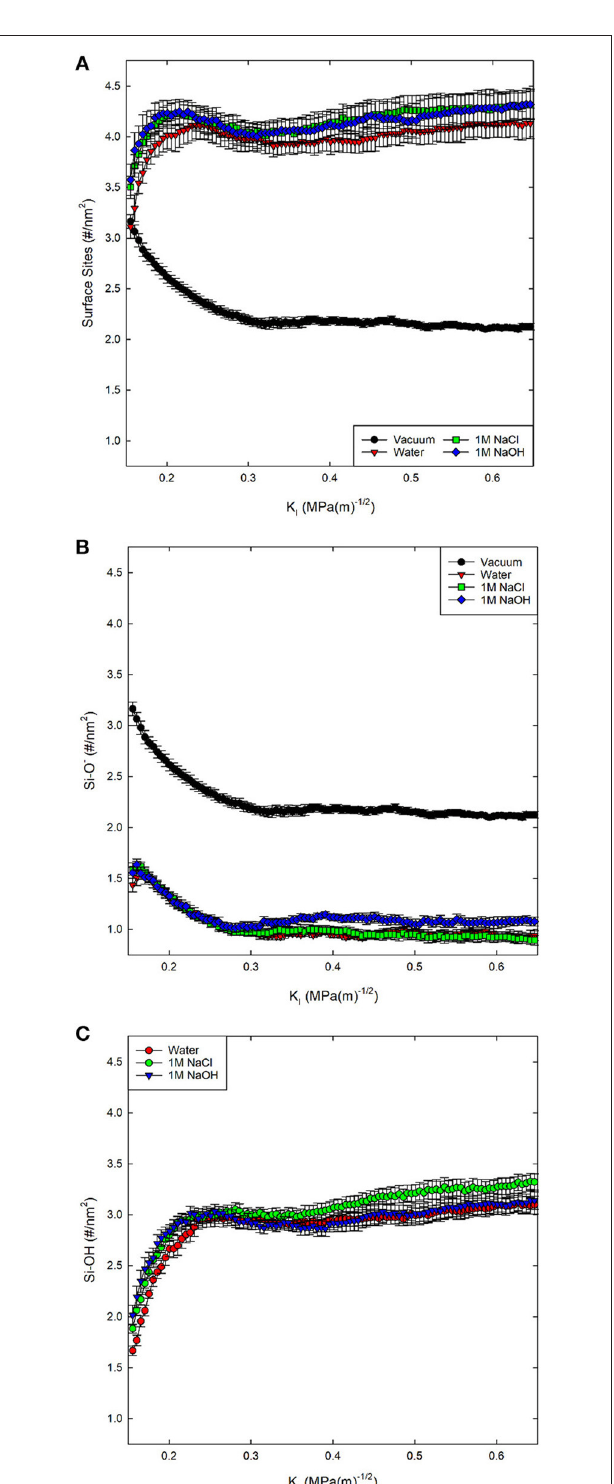
FIGURE 2 | Total concentration of (A) surface sites (Si-OH, Si-O − , Si-OH 2 ) on the fracture surfaces of silica in four environmental conditions, (B) the concentration of Si-O − , and (C) Si-OH on the surface. No Si-OH sites are present under vacuum conditions. K I indexes the far-field mechanical loading and fracture occurs at a K I of 0.25 MPa-m − 1 / 2 ∼